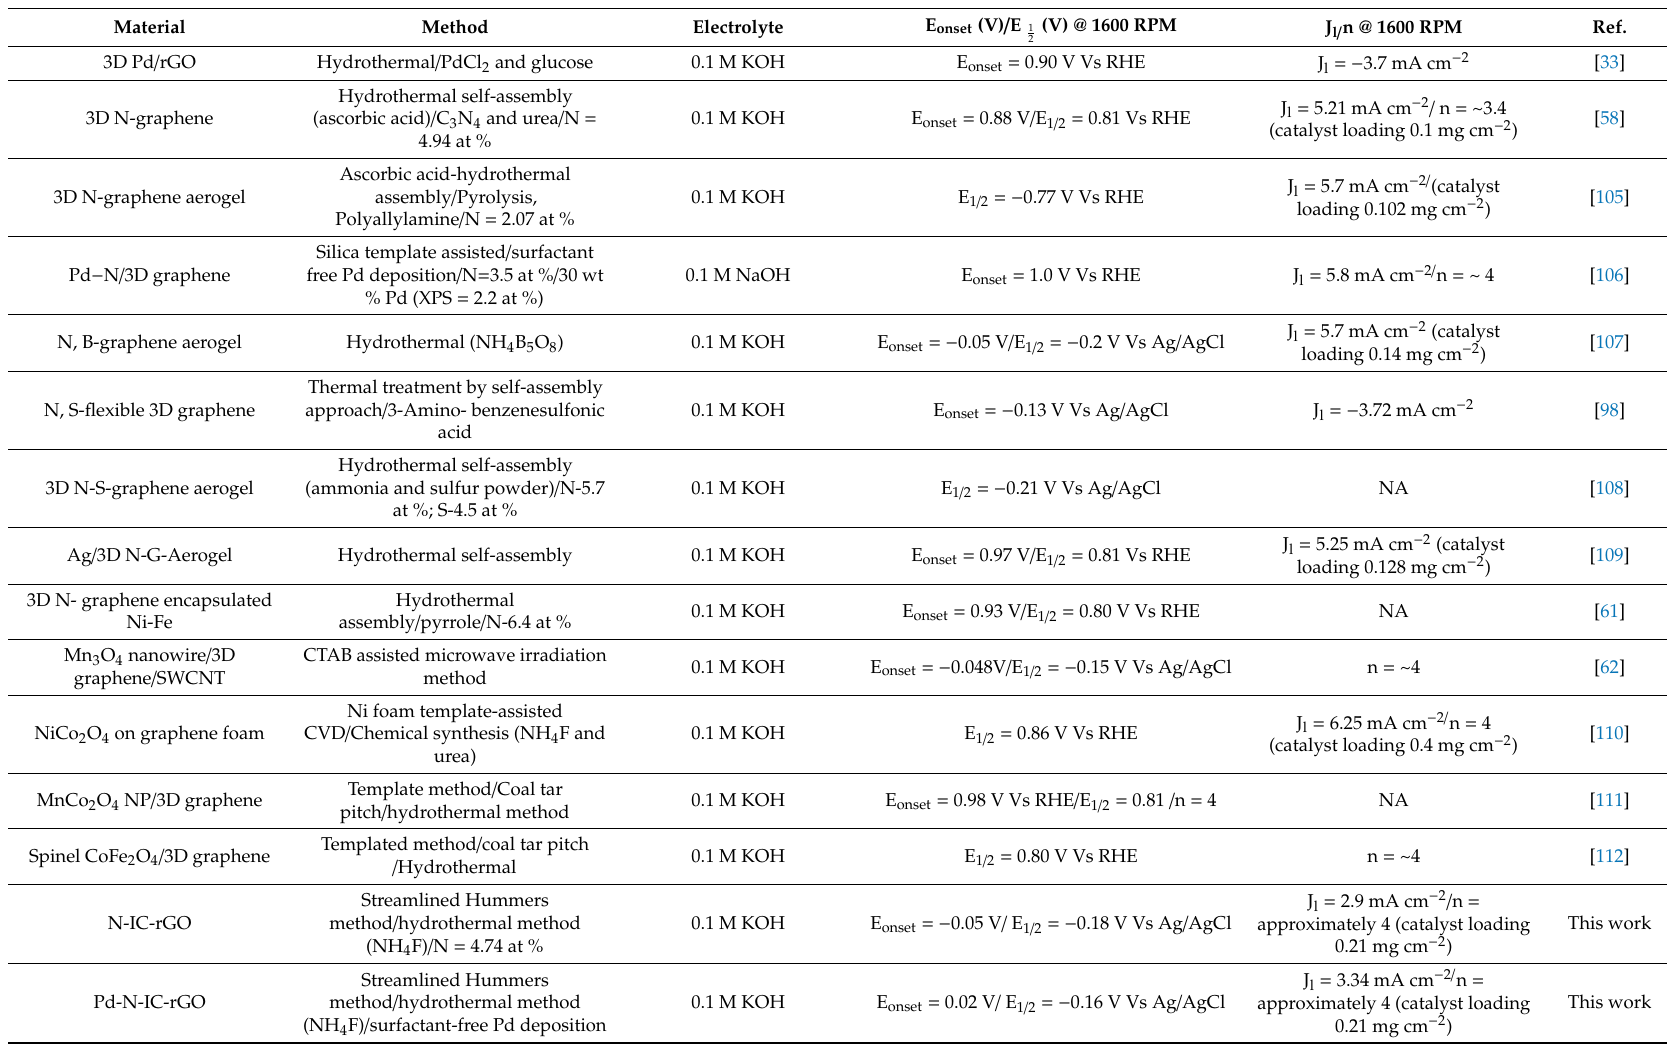
Table 3. Comparison of the oxygen reduction reaction (ORR) performance of di ff erent 3D-GNM